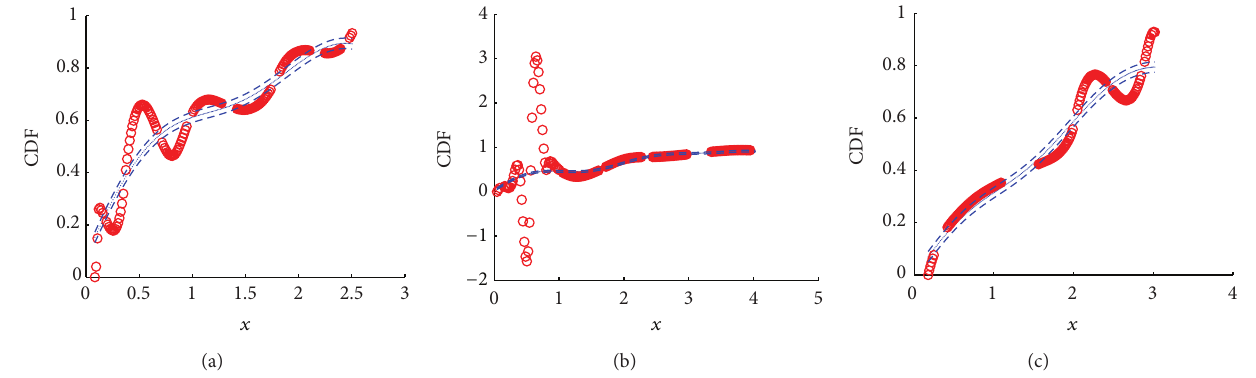
Figure 3: 𝜀 -insensitive